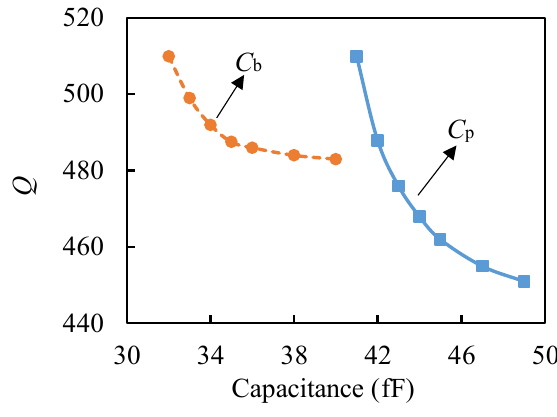
Figure 10. Effects of C b and C p on Q .